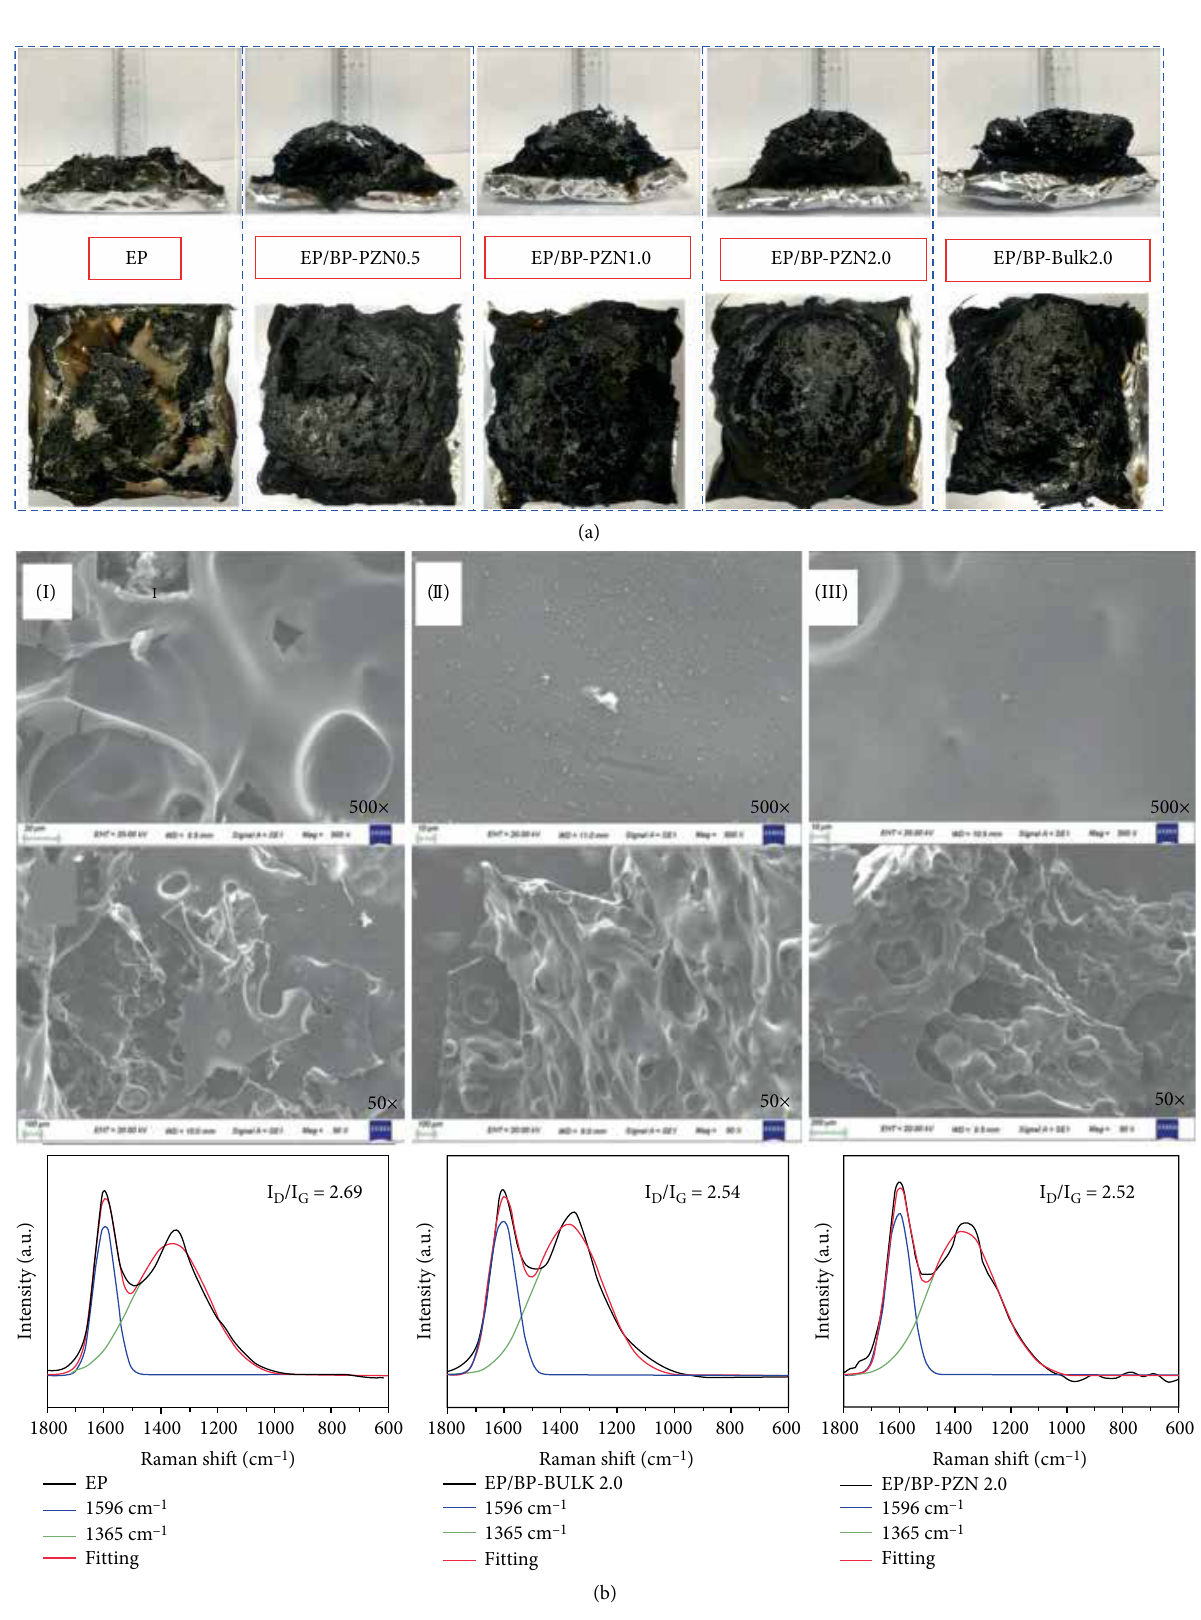
Figure 4: (a) Micrographs of external residues from a top and side view for EP and its nanocomposites. (b) SEM images and Raman spectra of external and interior char residues for (I) EP, (II) EP/BP-Bulk2.0, and (III) EP/BP-PZN2.0 nanocomposites. Adapted from